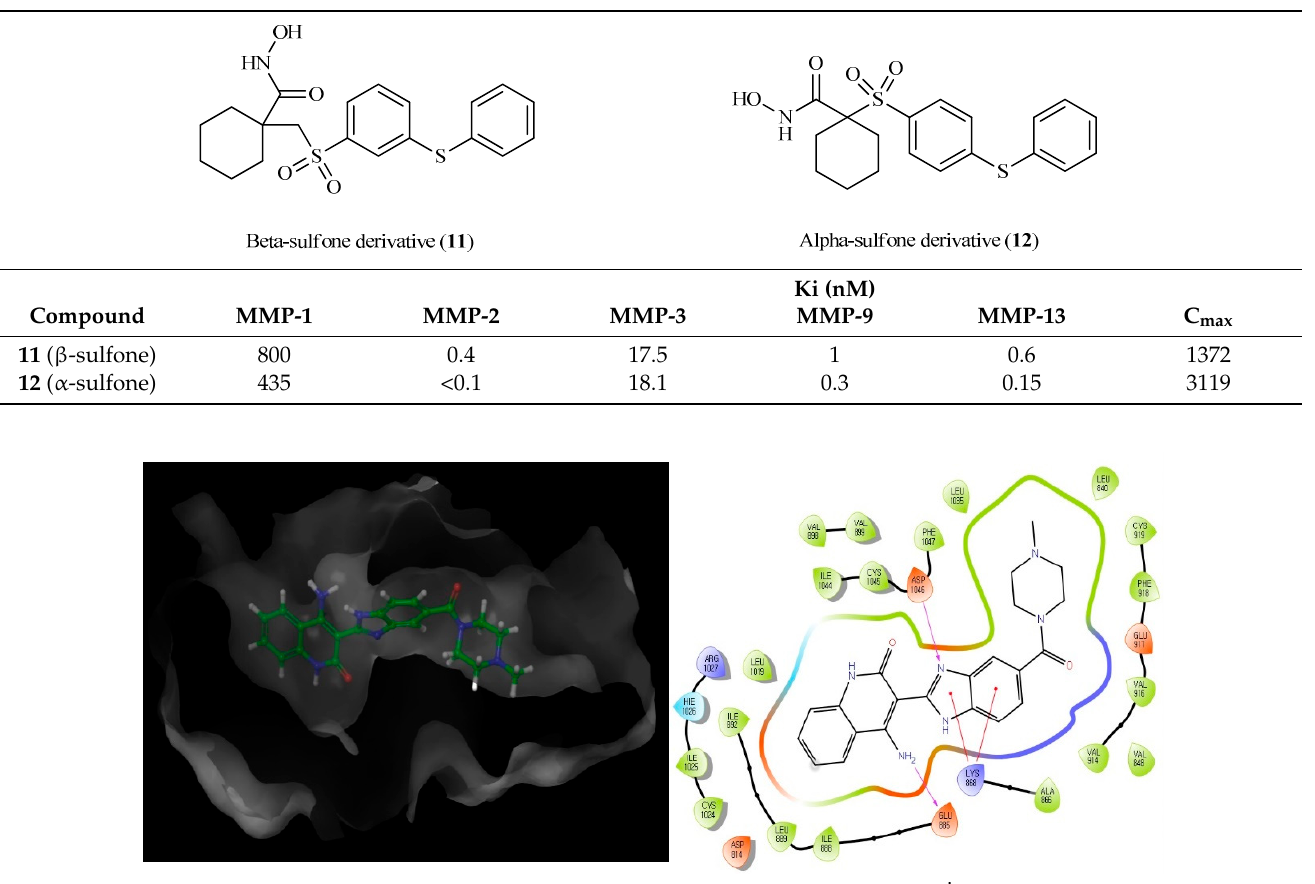
Table 2. Comparing α - and β -sulfone derivatives for their matrix metalloproteinase 1 (MMP-1) activity [50].